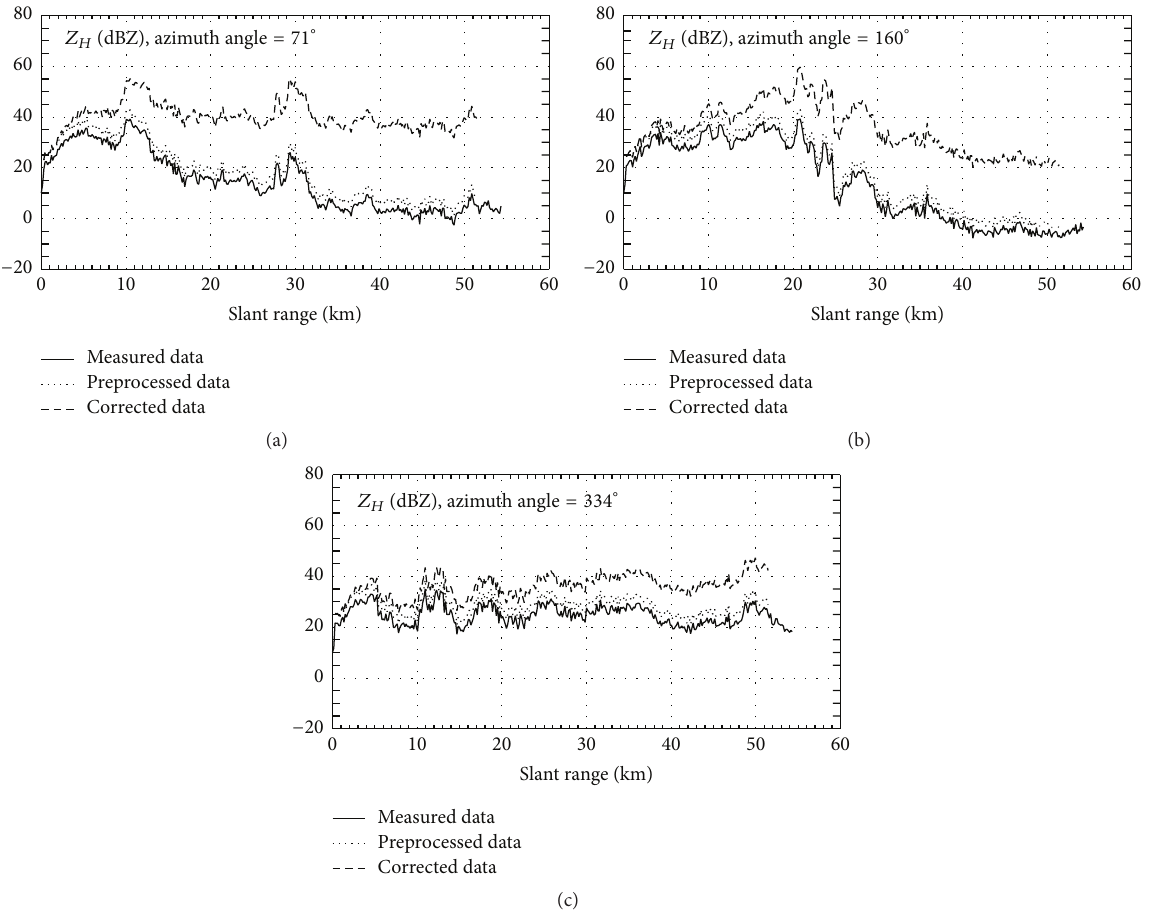
Figure 8: Range profiles of measured (line); calibration bias, 𝜌 (dash) 𝑍 𝐻 at 71 ∘ (a), 160 ∘ (b), and 334 ∘ (c) azimuth angles of NIMS-XPOL for the case in Figure